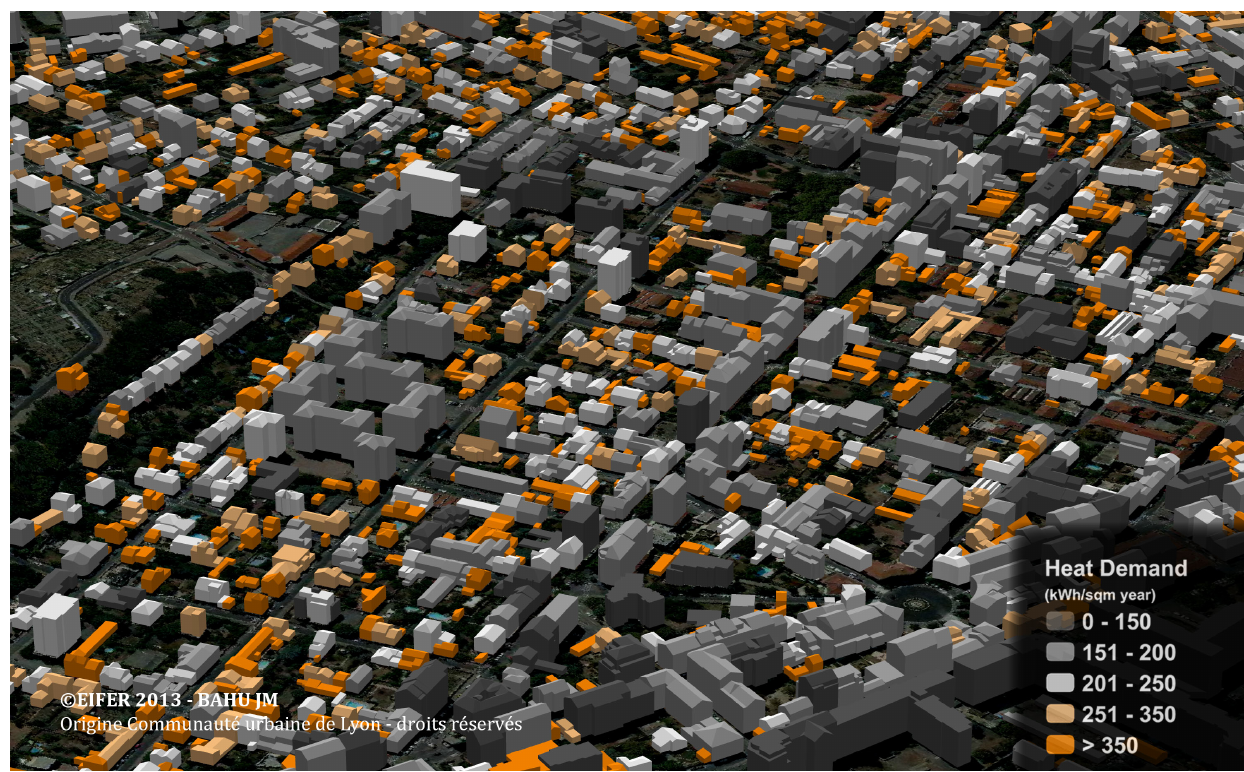
Figure 4. Results of the estimation of the heat demand of buildings. (Image courtesy of Jean-Marie Bahu, EIFER